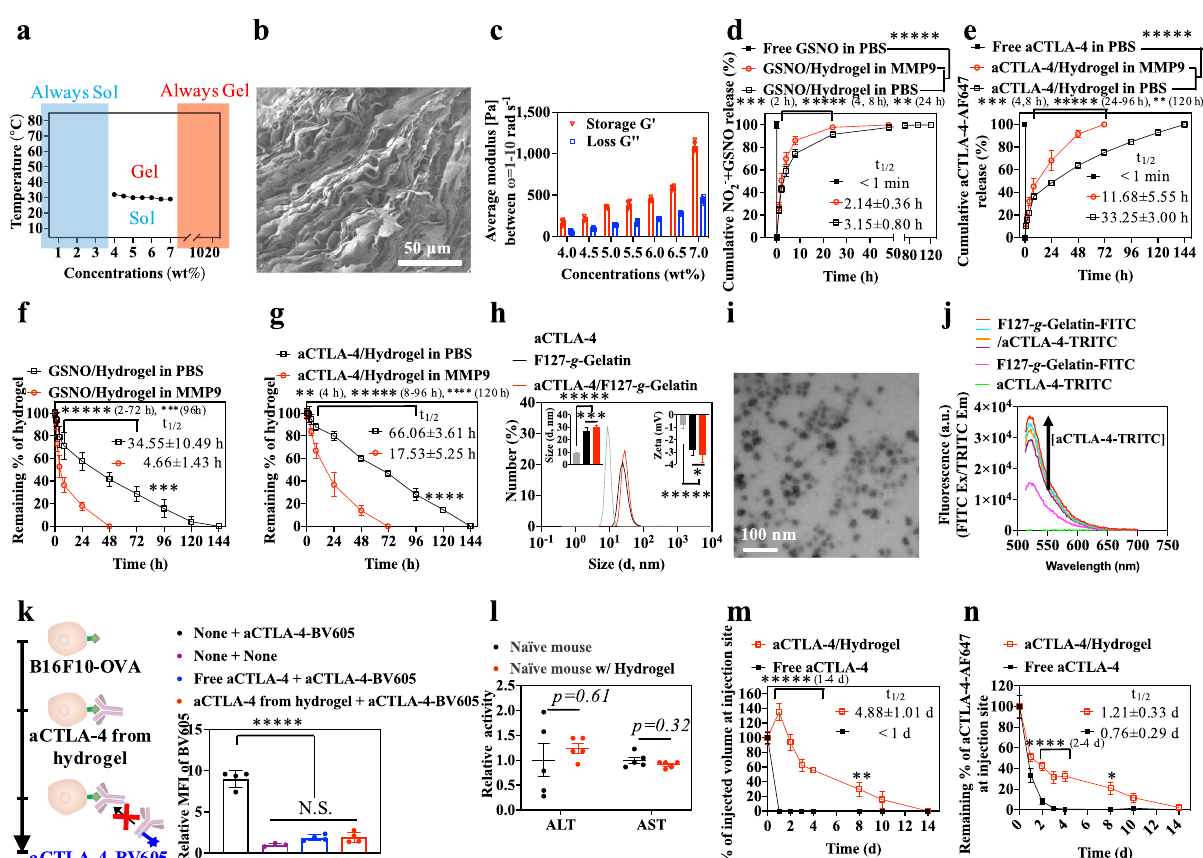
Fig. 4 In vitro and in vivo physicochemical properties, residence stability, and drug release behavior of thermosensitive hydrogels formed from F127- g -Gelatin. a Concentration-dependent sol-gel transition properties of F127- g -Gelatin. b Representative SEM image of F127- g -Gelatin hydrogel ( n = 3). c Concentration-dependent storage (G') and loss (G'') modulus of F127- g -Gelatin at 37 °C ( n = 3 for 4.5 wt.%, n = 4 for 5.5, 6.0, 6.5, and 7.0 wt.%, and n = 5 for 4.0 and 5.0 wt.%.). d , e Cumulative release of ( d ) NO 2 − + GSNO ( n = 4) and ( e ) Alexa Fluor TM 647 labeled aCTLA-4 ( n = 3) from 4.5 wt% F127- g -Gelatin into PBS with or without MMP9. f , g In vitro residence stability of ( f ) GSNO ( n = 4) and ( g ) Alexa Fluor TM 647 labeled aCTLA-4 ( n = 3) containing 4.5 wt% F127- g -Gelatin in PBS with or without MMP9. h DLS size distribution of aCTLA-4 and supernatants released from F127- g -Gelatin hydrogel (F127- g -Gelatin) or F127-g-Gelatin hydrogel containing aCTLA-4 (aCTLA-4/F127- g -Gelatin) ( n = 12). The left and right insets represent the average size ( n = 12) and zeta potentials ( n = 6 for aCTLA-4, and n = 12 for the other) of materials, respectively. i Representative TEM image of F127- g - Gelatin micelles in situ released from F127- g -Gelatin thermosensitive hydrogel ( n = 3). j FRET analysis with aCTLA-4-TRITC and F127- g -Gelatin-FITC at FITC excitation and TRITC emission ( n = 4). k Competitive assay to verify the activity of aCTLA-4 released from F127- g -Gelatin hydrogel ( n = 3 for None + None, and n = 4 for the other). l ALT/AST activities of blood taken from mice 2 d after subcutaneous administration of 4.5 wt.% F127- g -Gelatin hydrogel ( n = 5). m In vivo residence stability of 4.5 wt.% F127- g -Gelatin hydrogel quanti fi ed by time-resolved volume of hydrogel remaining at the injection site ( n = 4). n In vivo quanti fi cation of aCTLA-4-AF647 remaining at the injection site by using IVIS ® resulting from formulation in the 4.5 wt.% F127- g -Gelatin hydrogel ( n = 4). Data are presented as mean ± SD for c – h and j , k , and mean ± SEM for l – n . *****p < 0.0001, ****p < 0.001, ***p < 0.01, **p < 0.05, and *p < 0.1. Exact p -values for d – h , k , m , and n are reported in the source fi le. d – g , m , n Two-way ANOVA using Tukey post-hoc statistical hypothesis. h , k One-way ANOVA using Tukey post-hoc statistical hypothesis. l Two-tailed Student t -test. Source data are available in a Source Data fi